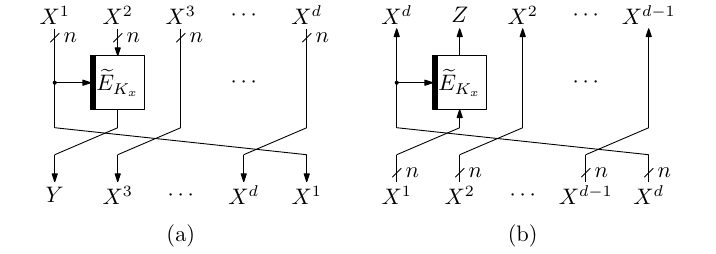
]( X 1 ∥· · ·∥ X d ) = ( Y ∥ X 3 ∥· · ·∥ X d ∥ X 1 ), where Y = e E Figure 3: (a) Φ 1 ,d [ e E K x (b) Φ − 1 [ e E ]( X 1 ∥ · · · ∥ X d ) = ( X d ∥ Z ∥ X 2 ∥ · · · ∥ X d − 1 ), where Z = e E − 1 K x 1 ,d